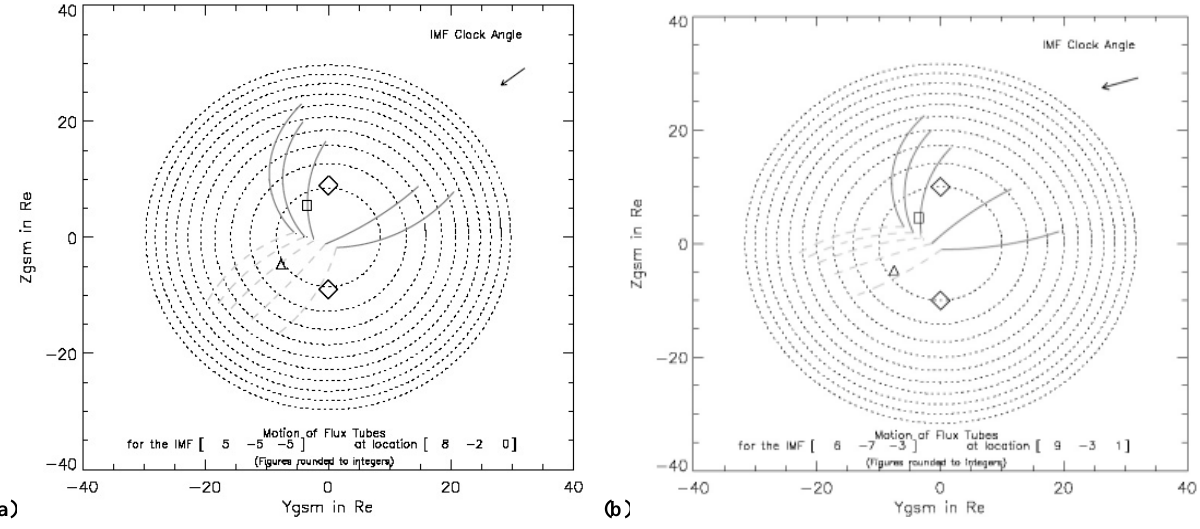
Fig. 4. Results from the Cooling model. The figure is projected in the YZ plane, looking earthward from the Sun. The concentric dotted circles represent the radius of the magnetopause at 5R E intervals along the X direction, with the innermost circle representing X=5R E . The diamonds represent the position of the cusps for a magnetopause standoff distance of 9R E . The triangle represents the position of Double Star and the square the position of Cluster at the time of the FTE in question. Pairs of open reconnected flux tubes are initiated along the merging line (dot-dashed), with the motion of each tube calculated for a total of 500s, which is represented by the extent of the line, with the solid line representing flux tubes connected to the northern cusp, and the dashed lines connected to the southern cusp. The IMF orientation is indicated by an arrow in the upper right hand of the figure and the components are stated at the bottom of the plot. The location information pertains to the mid point of the merging line. Other parameters are discussed in the text. Panel (a) shows the results for parameters representing the FTE signature seen at Cluster ∼ 05:20 UT and at TC-1 at ∼ 05:18:50 UT. Panel (b) shows the effect of modifying the IMF clock angle which moves the region of FTE evolution such that one can envisage Double Star to move out of this region under certain clock angle values.